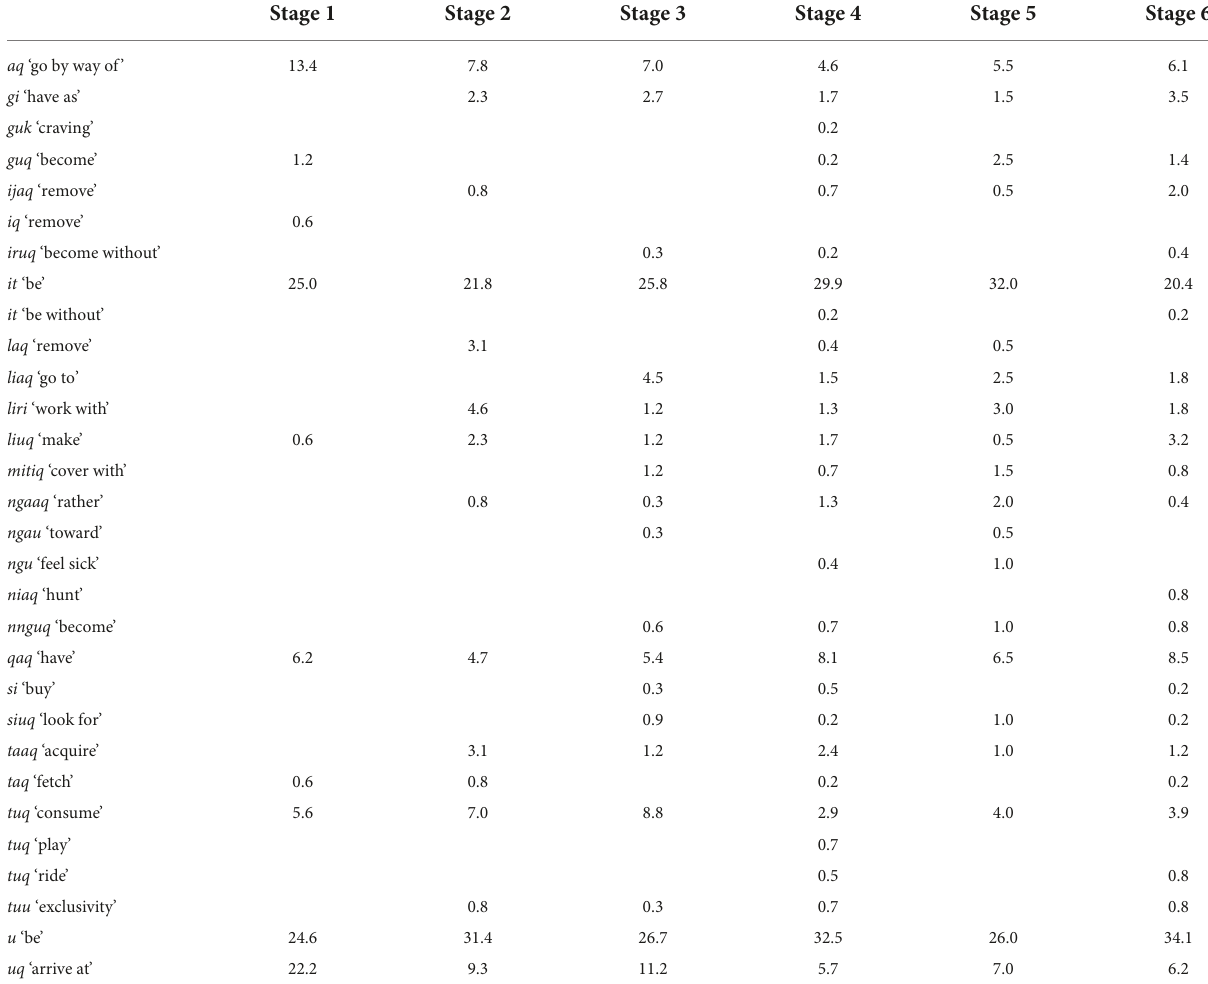
TABLE 6 Frequencies of verbalizers as a percentage of the total number of verbalizers used in the data, by stage. Stage 1